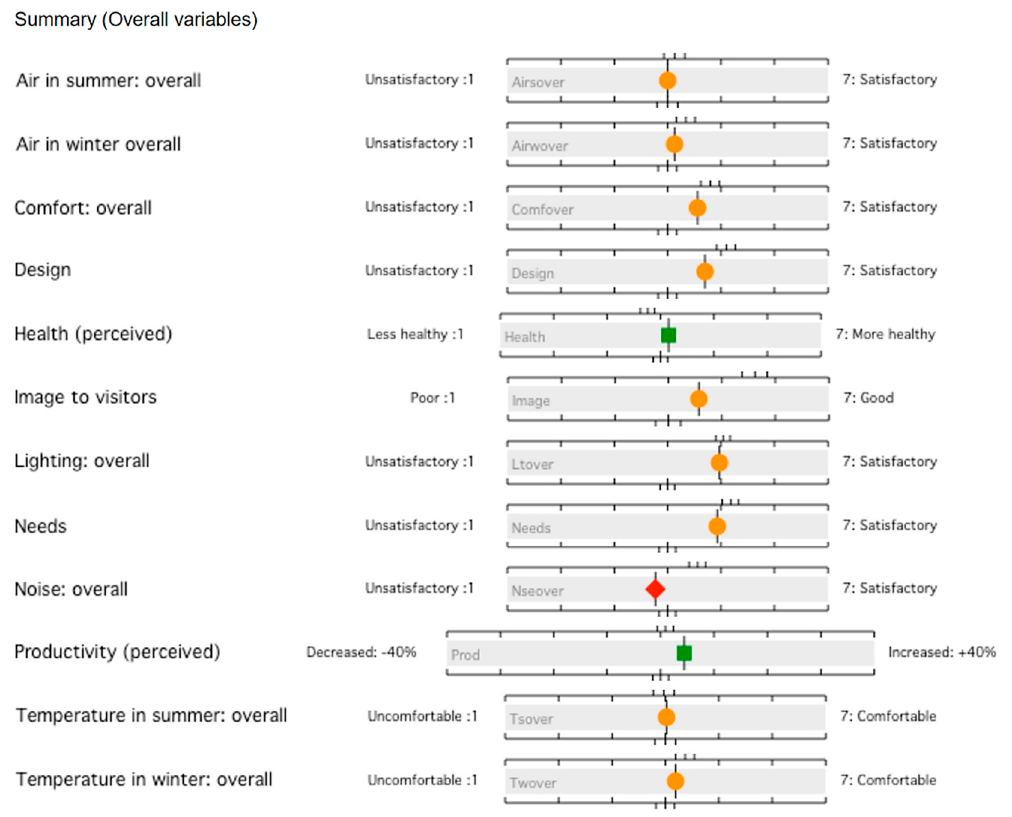
Figure 19. Post Occupancy Evaluation summary chart for students (source: Building Use Studies).